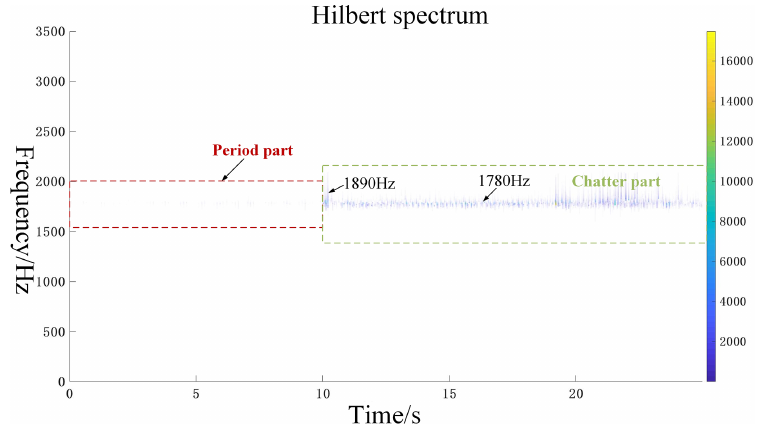
Figure 11. Time–frequency analysis of the a 6 frequency segment.